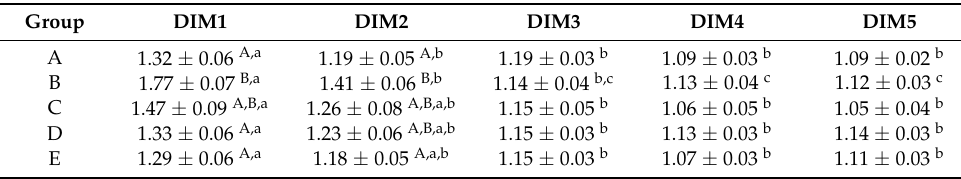
Table 5. F:P ratio pattern by group over the first five months of lactation. Group